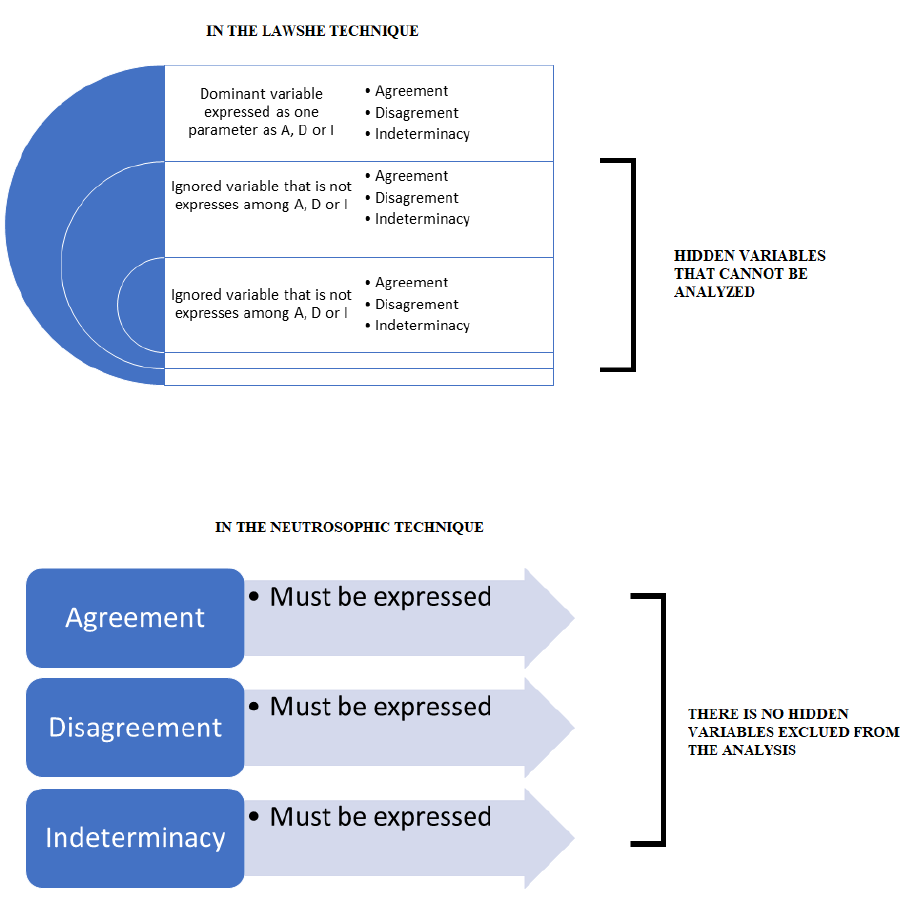
Fig. 7. There is no hidden variable in the neutrosophic technique but there are hidden variables in the Lawshe